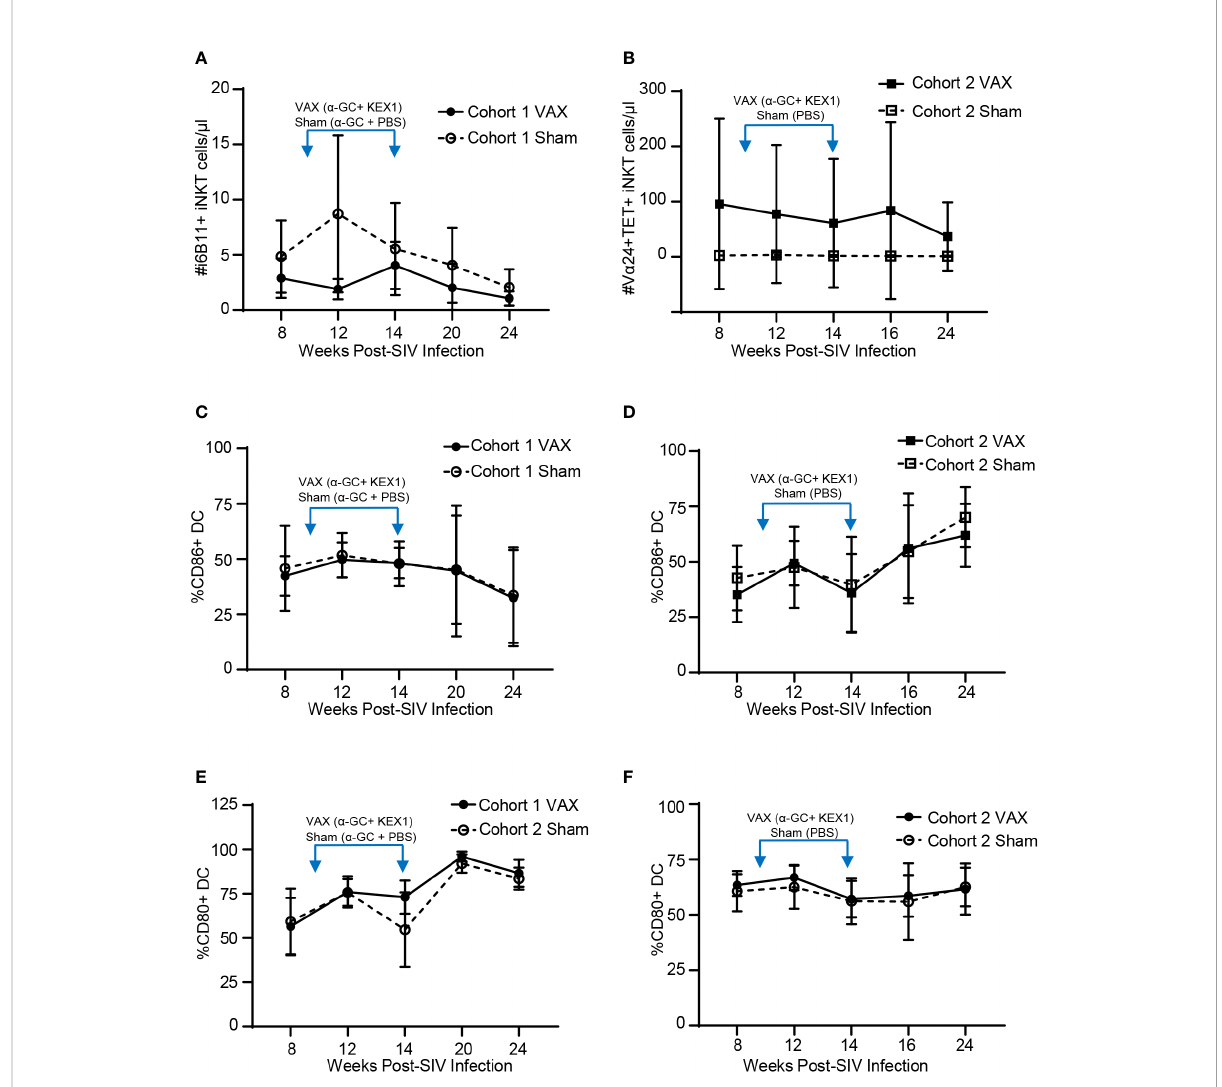
FIGURE 3 Evaluation of peripheral blood iNKT cells and dendritic cells following therapeutic boosting with a -GC+KEX1. (A, B) Cell numbers of peripheral blood iNKT cells, (C, D) frequencies of CD86+ dendritic cells (DC) and (E, F) frequencies of CD80+ DC in macaques therapeutically boosted at 10 and 14 weeks post-infection (blue arrows) as indicated. iNKT cells in Cohort 1 were identi fi ed by staining with the monoclonal antibody against the TCR V a 24-J a 18 (6B11+) where as iNKT cells in Cohort 2 were de fi ned as V a 24+CD1d tetramer PBS-57 (TET+). Data represents the mean ± SD. Statistical signi fi cance between VAX and Sham groups over time were evaluated by repeated measures mixed modeling analysis using the Geisser-Greenhouse model correction and Sidak correction for multiple